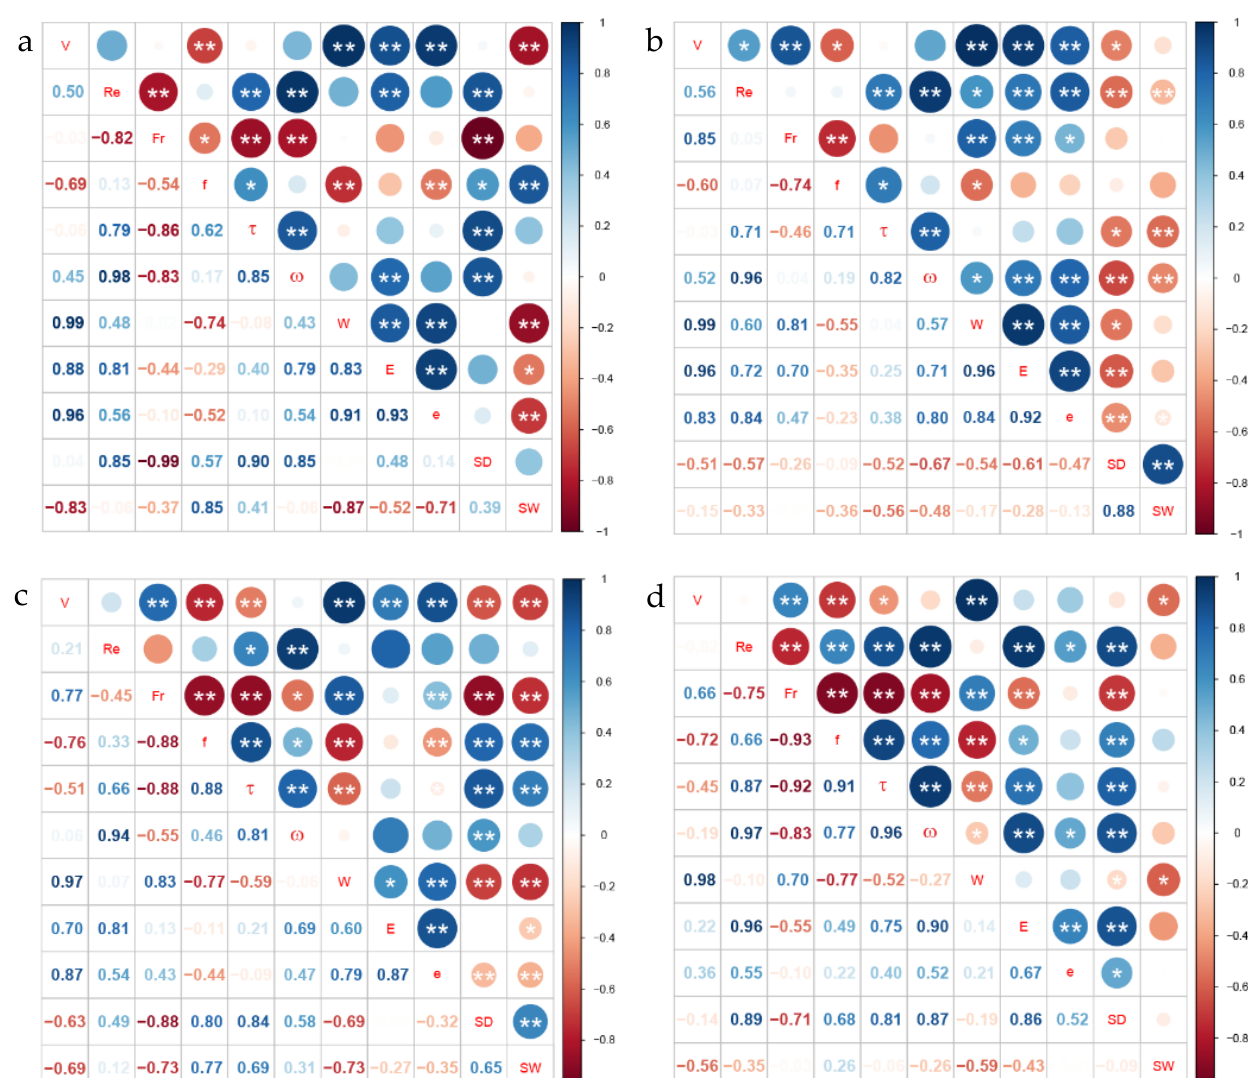
Figure 7. ( a – d ) represent the correlation matrices of hydraulics in the gully development processes of A-layer incision, A-layer expansion, B-layer incision, stabilization on the steep slope, respectively. V is flow velocity, ** represents p < 0.01, * represents p < 0.05.